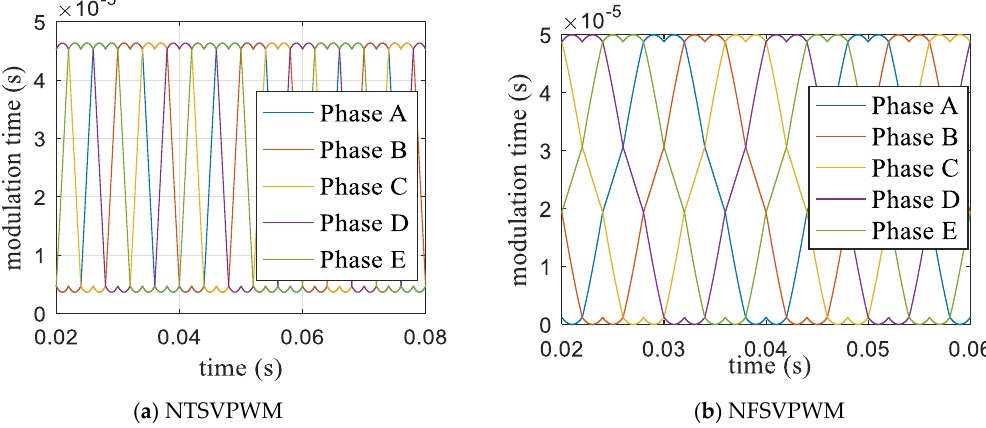
Figure 10. Five-phase modulation time based on traditional algorithms.